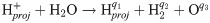
Example of a SLEND/6-31G* simulation of H+ + H2O leading H2O to fragment into H2 and O.Panels 1 to 5 are frames of this simulation animation, where colored spheres represent the nuclei (white = H and red = O) and colored clouds represent selected electron density iso-surfaces (from red = lowest density to blue = highest density). Panel 6 shows the Mulliken populations of the projectile Hproj. and of the O and H2 moieties of/from H2O vs. time in a.u. Mulliken populations at final time indicate that Hproj++H2O→Hprojq1+H2q2+Oq3 with q1 = 1−N1 = +1, q2 = 2−N2 = 0 and q3 = 8−N3 = 0.